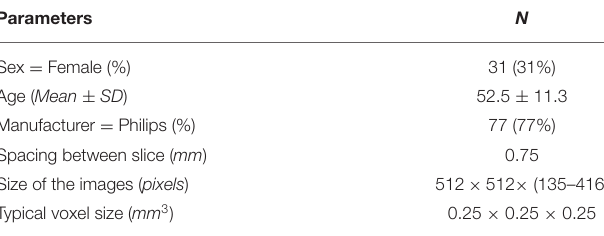
TABLE 1 | Characteristics of the ImageTBAD